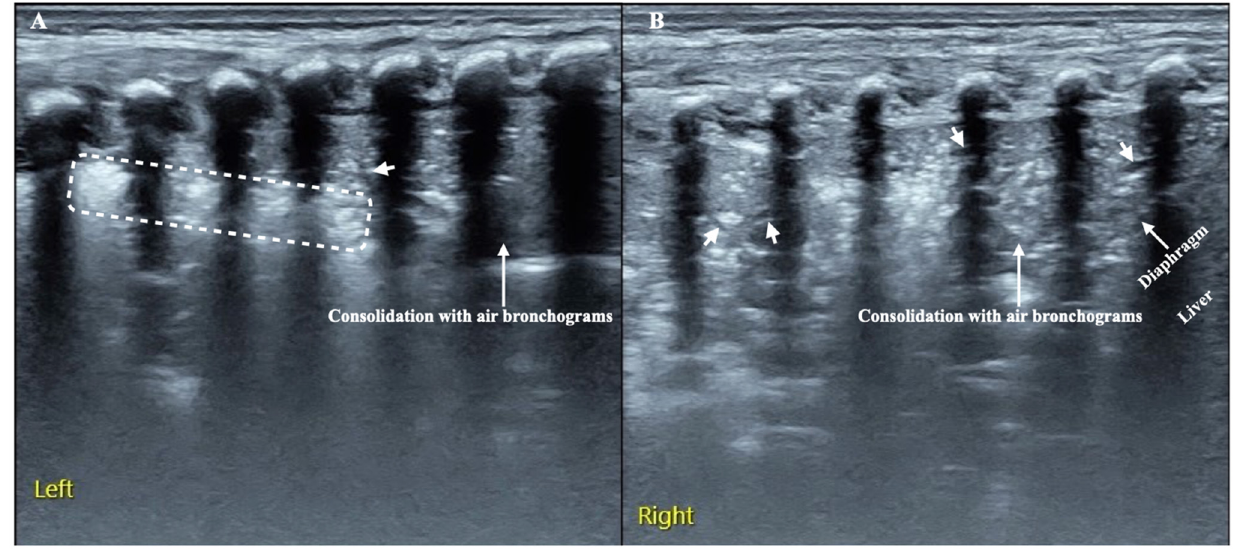
Figure 2. LUS manifestations of neonatal fungal pneumonia. It can be seen from the picture that both lungs have massive consolidation with air bronchograms, which resulted in severe atelectasis. Shred signs can be seen at the edge of the consolidation area. In addition, there are some minor fluid bronchograms can be found in bilateral lung fields (arrows). ( A ): left lung; ( B ): right lung. (Arrows: lung consolidation with air bronchograms. Dotted box: shred signs).